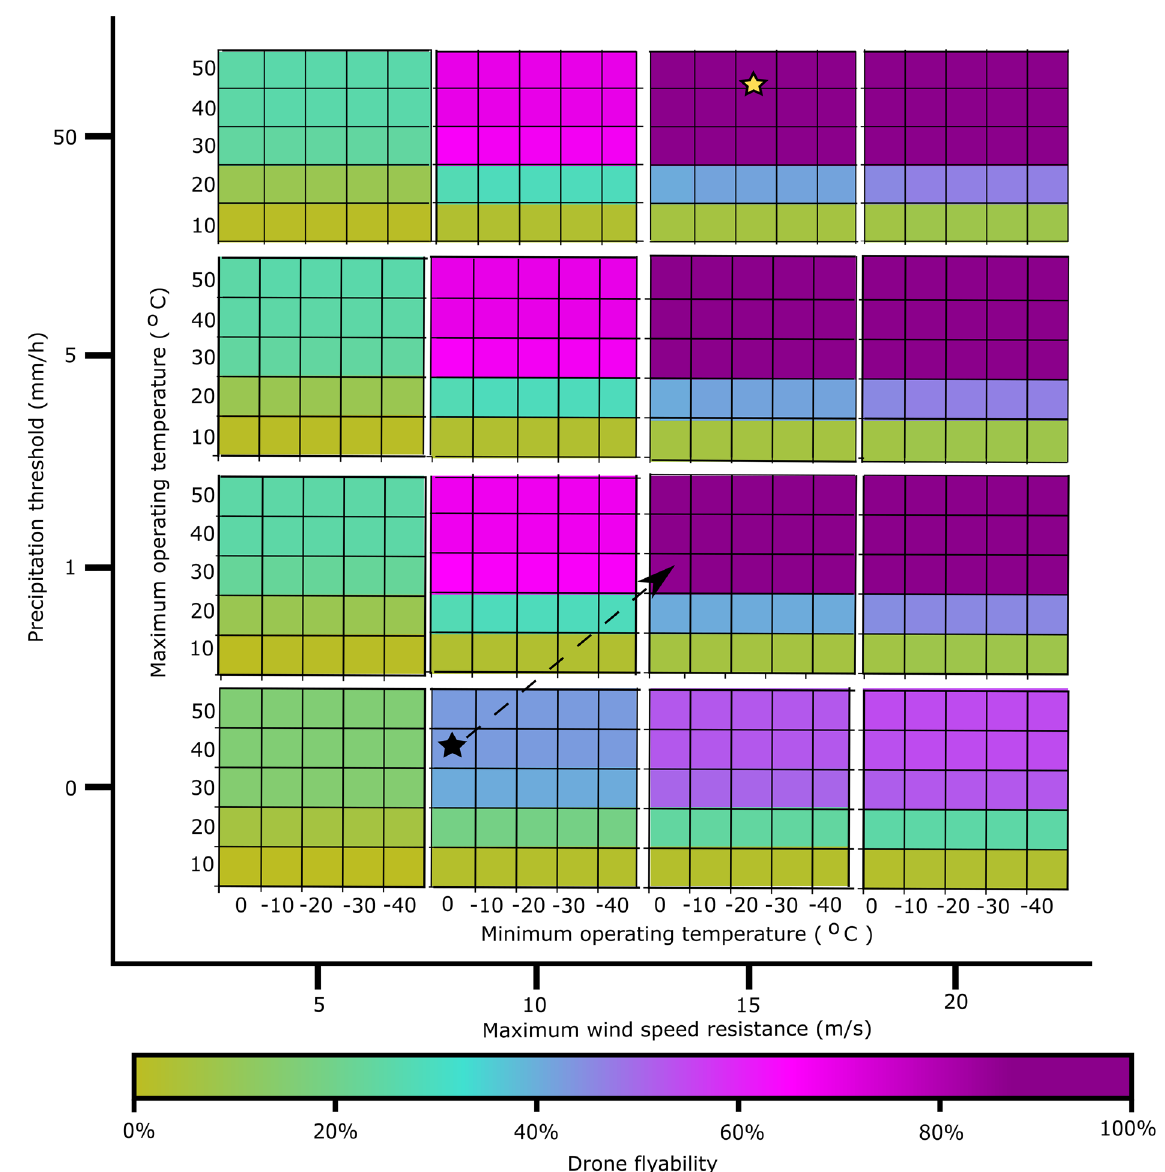
Figure 5. Multivariate matrix of drone flyability as influenced by air temperature, wind speed, and precipitation in the 100 most populated world cities 21 . Each interior plot shows median flyability as a function of minimum and maximum temperature tolerances. The vertical position of interior plots corresponds to precipitation thresholds, the horizontal position of interior plots corresponds to maximum wind speed resistance. The stars correspond to the CD (black) and WRD (yellow) to benchmark potential flyability gains. The arrow shows the greatest opportunity for improving flyability for CDs—increasing precipitation threshold by 1 mm/h and maximum wind speed resistance by 5